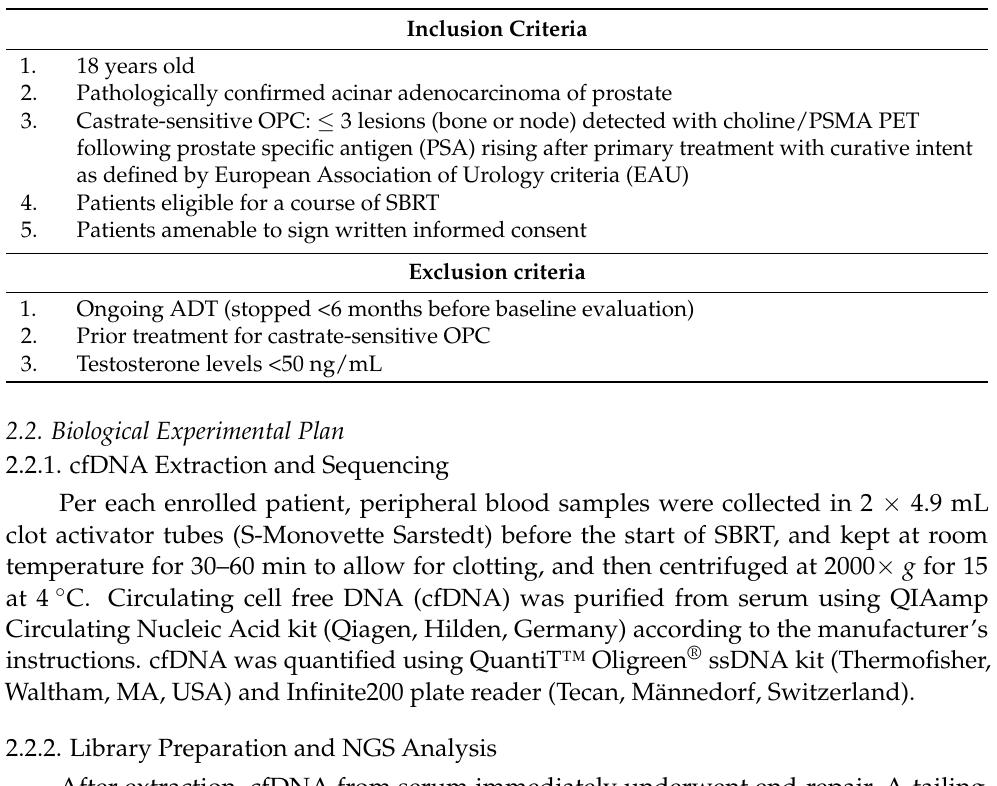
Table 1. Patient selection criteria.